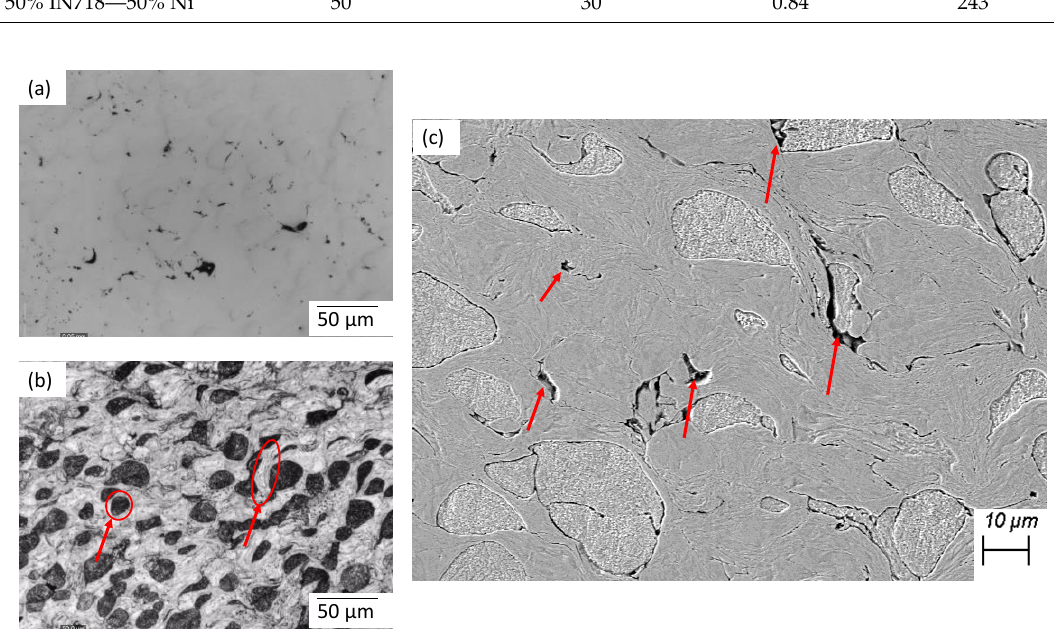
Table 5. Coating properties: IN718 retention in the final coating, porosity, and hardness. Coating